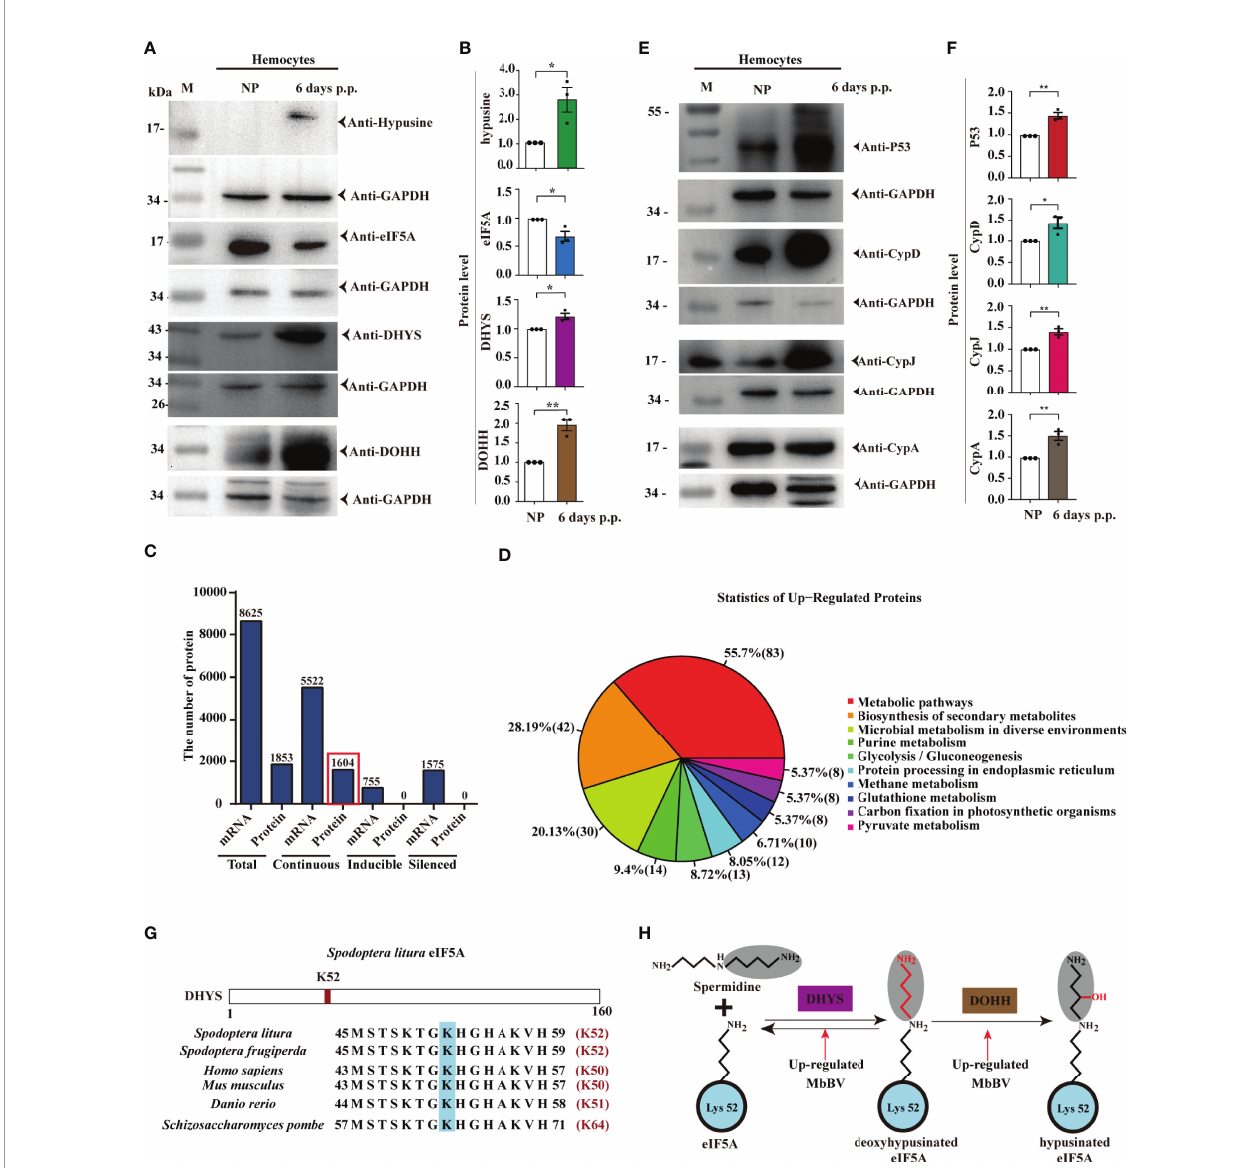
FIGURE 3 | Bracovirus integration triggered eIF5A hypusination. (A, B) Bracovirus integration increases the expression of hypusination, DHYS, and DOHH. * p < 0.05, ** p < 0.01, error bars represent SEM. Unpaired Student ’ s t -test with Holm-Sidak method for multiple t test; n = 3. (C) Expression of proteins and mRNAs under MbBV integration hypusination. Total, continuous, inducible, and silenced mRNA and proteins are identi fi ed. (D) Upregulated proteins are enriched in 10 pathways. (E, F) Upregulated proteins, P53, CypD, CypJ, and CypA, related to apoptosis, are detected. * p < 0.05, ** p < 0.01, error bars represent SEM. Unpaired Student ’ s t -test with Holm-Sidak method for multiple t test; n = 3. (G) eIF5A hypusination sites. (H) MbBV increased DHYS and DOHH expression and modi fi ed eIF5A hypusination. See also Figure S3 and Table S3